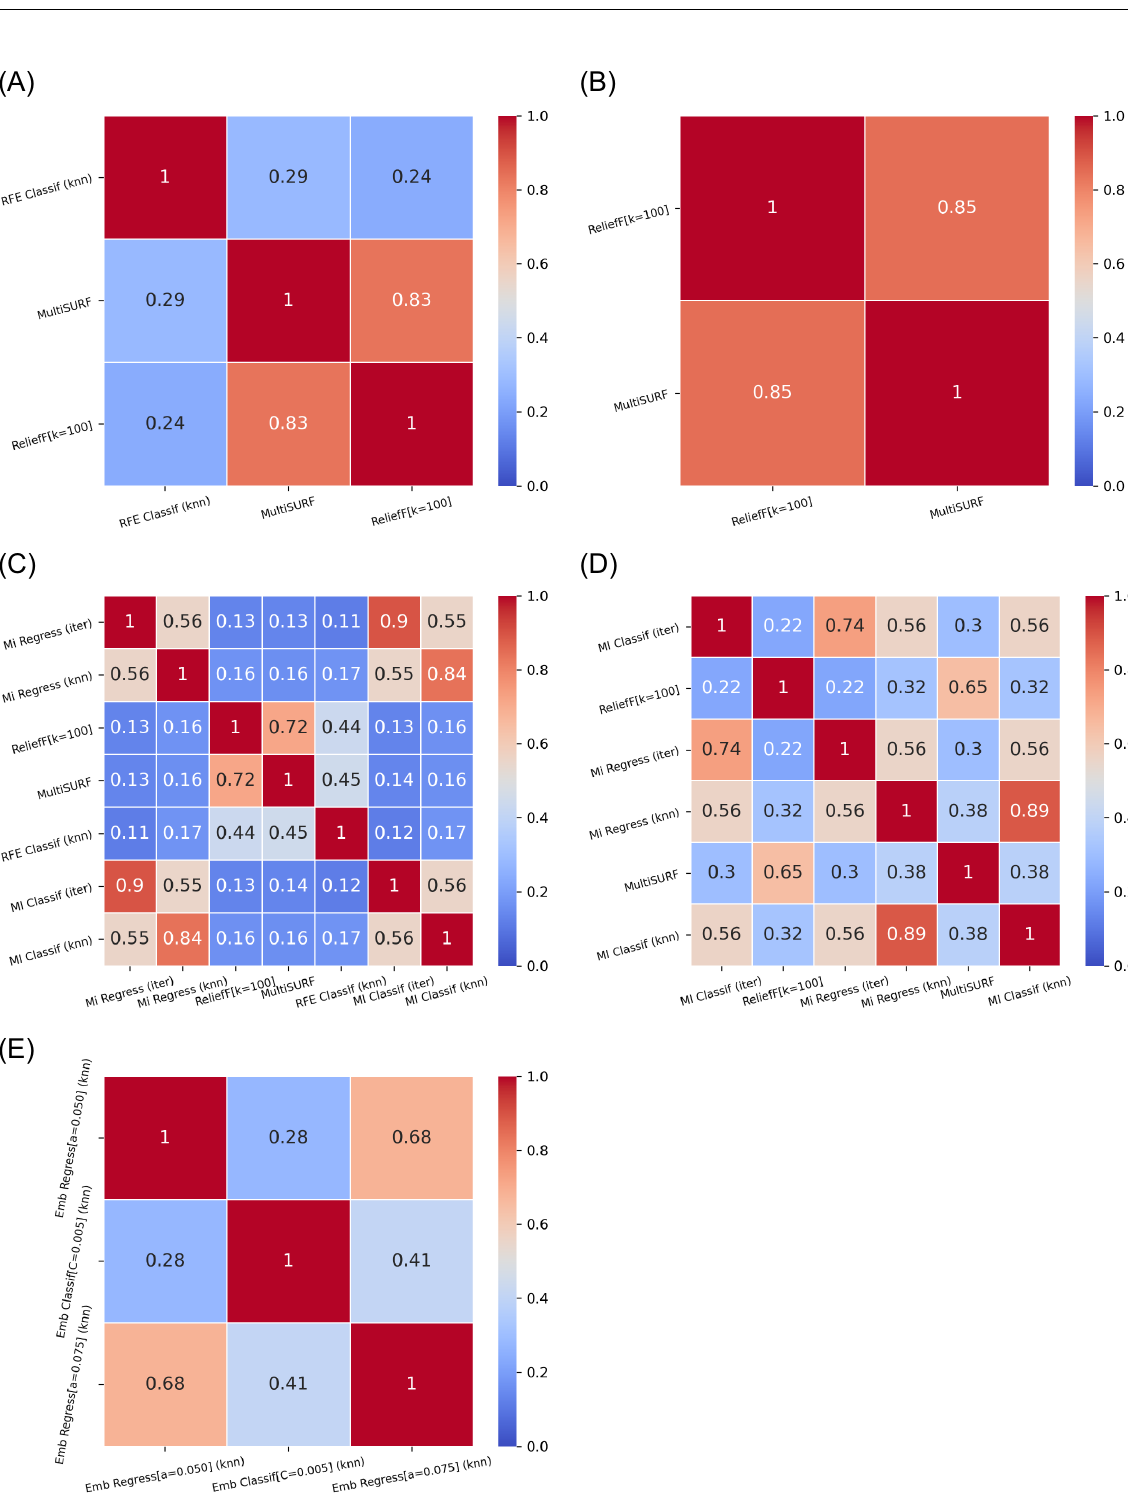
specification. Results were FS